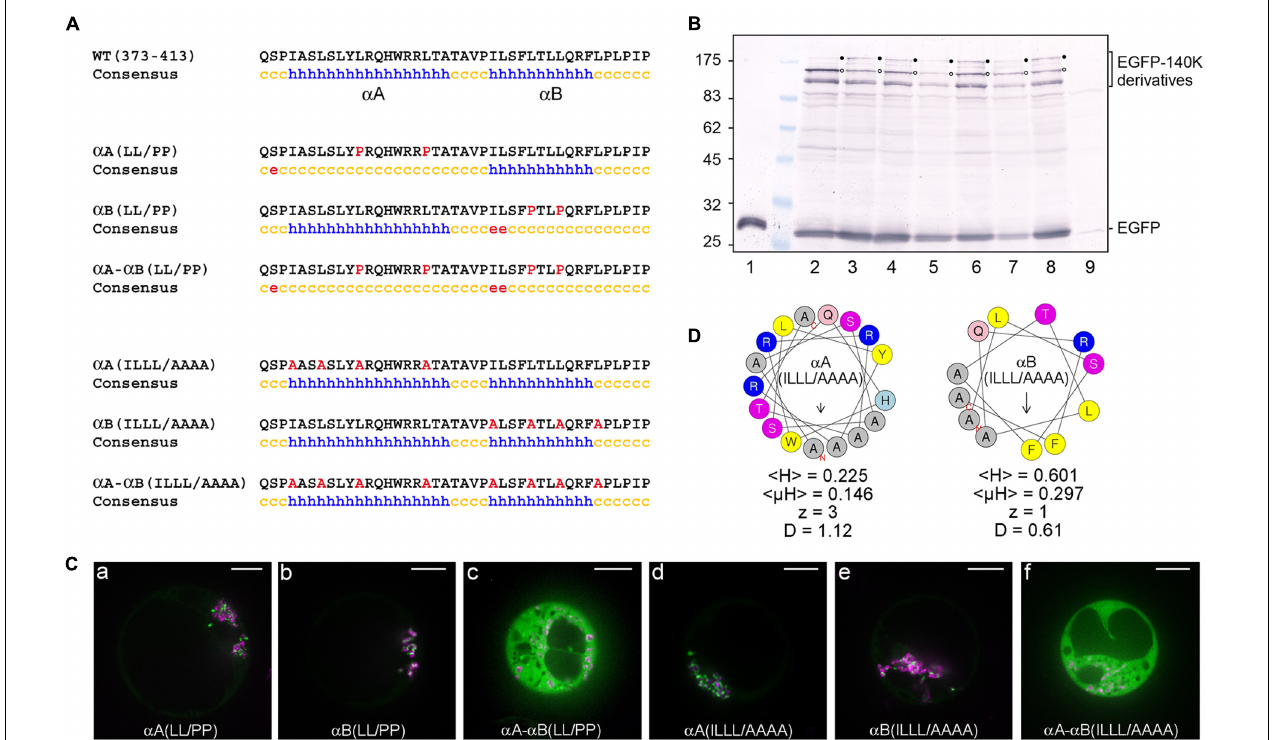
FIGURE 6 | The structure and amphipathic property of CTD α -helices is required for targeting 140K/98K to the chloroplasts. (A) Sequence and secondary structure predictions of altered CTD domain. Introduced substitutions are highlighted in red in the residue sequence. Secondary structure predictions were made using the same predictors as in Figure 4 but only the consensus prediction is shown (h: helix; c: coil; e: β -sheet). (B) Arabidopsis protoplasts were transfected with the expression plasmids p (cid:127) -EGFP (lane 1), p (cid:127) -EGFP-140K (lane 2), p (cid:127) -EGFP-140K- α A(LL/PP) (lane 3), p (cid:127) -EGFP-140K- α B(LL/PP) (lane 4), p (cid:127) -EGFP-140K- α A- α B(LL/PP) (lane 5), p (cid:127) -EGFP-140K- α A(ILLL/AAAA) (lane 6), p (cid:127) -EGFP-140K- α B(ILLL/AAAA) (lane 7), p (cid:127) -EGFP-140K- α A- α B(ILLL/AAAA) (lane 8), or with water (lane 9). The cells were harvested 48 hpt and equivalent amounts of total proteins (except lane 1 which corresponds to 1/20th of the other samples) were subjected to 10% SDS-PAGE and immunoblot analysis with anti-GFP antibodies. Molecular mass markers (Biolabs) are indicated on the left whereas positions of EGFP-140K derivatives and EGFP are indicated on the right. Filled dots indicate the position of full-length proteins, whereas open dots indicate the position of the mature product after processing at the (PRO ↓ HEL) cleavage site. (C) Arabidopsis protoplasts were transfected with the expression plasmids p (cid:127) -EGFP-140K- α A(LL/PP) (a) , p (cid:127) -EGFP-140K- α B(LL/PP) (b) , p (cid:127) -EGFP-140K- α A- α B(LL/PP) (c) , p (cid:127) -EGFP-140K- α A(ILLL/AAAA) (d) , p (cid:127) -EGFP-140K- α B(ILLL/AAAA) (e) or p (cid:127) -EGFP-140K- α A- α B(ILLL/AAAA) (f) , together with p (cid:127) -RbCS-NiRFP. Single protoplasts were observed by spinning-disk confocal laser microscopy (SPCLM) 48 hpt and EGFP localization was observed (green). To visualize the localization of chloroplasts, NiRFP fluorescence and chlorophyll autofluorescence were acquired (magenta) and superimposed onto the EGFP fluorescence. Scale bars, 10 µ m. (D) Helical wheel representation of α A(ILLL/AAAA) and α B(ILLL/AAAA) helices using the HeliQuest server. Color code and helix characteristics are the same as in Figure 4